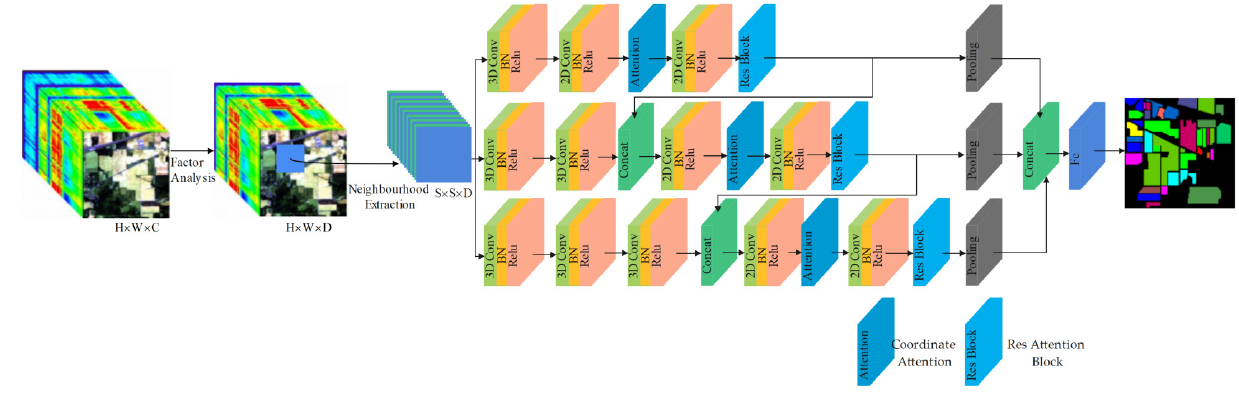
Figure 1. The framework of the proposed model.